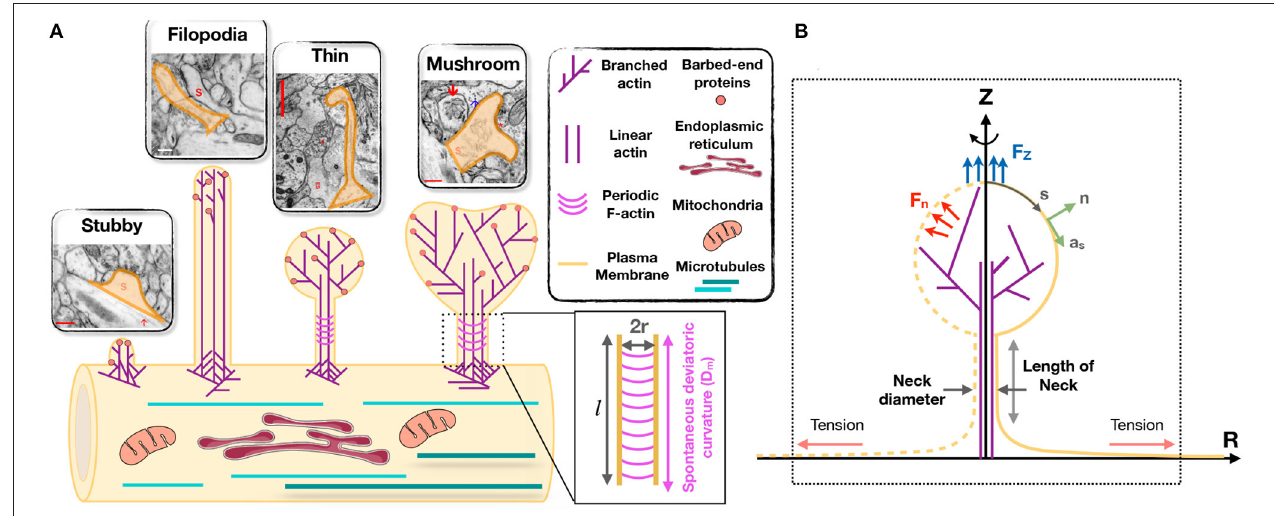
FIGURE 1 | Modeling of forces relevant to spine shape. (A) Schematic depiction of different shape categories of dendritic spines (Reprinted with permission from SynapseWeb, Kristen M. Harris, PI, http://synapseweb.clm.utexas.edu/). The inset shows a schematic of a tubular neck with a radius r and a spontaneous deviatoric curvature D m along the total neck length l . (B) The surface parametrization of the membrane geometry in axisymmetric coordinates. s is the arclength, n is the unit normal vector to the membrane surface, and a s is the unit tangent vector in the direction of arclength. We assume that the actin filaments can apply axial (F z ) or normal (F n ) forces to the membrane surface. We assume that there is a large membrane reservoir with a fixed area, and we focused on the local region of the membrane under tension λ , as indicated by the dotted